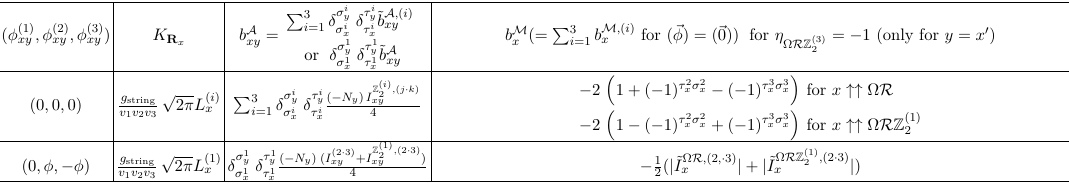
Table 25 . K(cid:127)ahler metrics K R with two-torus volumes v i de(cid:12)ned in (4.5) and one-cycle lengths x L ( i ) x in (3.4) for matter representations R x 2 f ( N x ; N y ) ; ( N x ; N y ) ; ( Anti x ) ; ( Sym ) g and contribu- x tions to the beta function coe(cid:14)cients from annulus and M(cid:127)obius strip topologies, b A , b M . For xy x details on the computation of Z 2 -invariant intersection numbers, the interested reader is referred to e.g. [2, 25]. The factor ( (cid:0) 1) 2 b i (cid:27) i x (cid:28) i x appearing in the M(cid:127)obius strip contribution to the beta function coe(cid:14)cient is required for consistency of spectra on tilted tori ( b i = 1 ) as (cid:12)rst noted in the caption 2